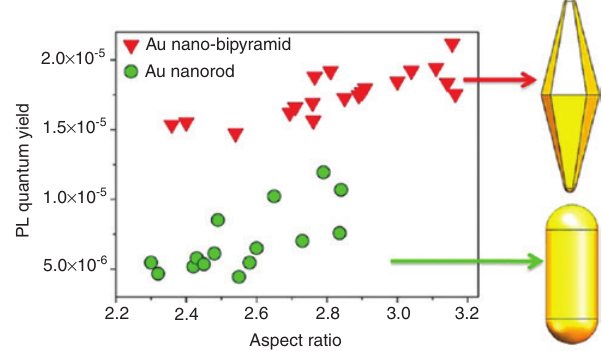
Figure 12: PL quantum yield for various aspect ratios of gold nanorods and bipyramids. Reprinted with permission from